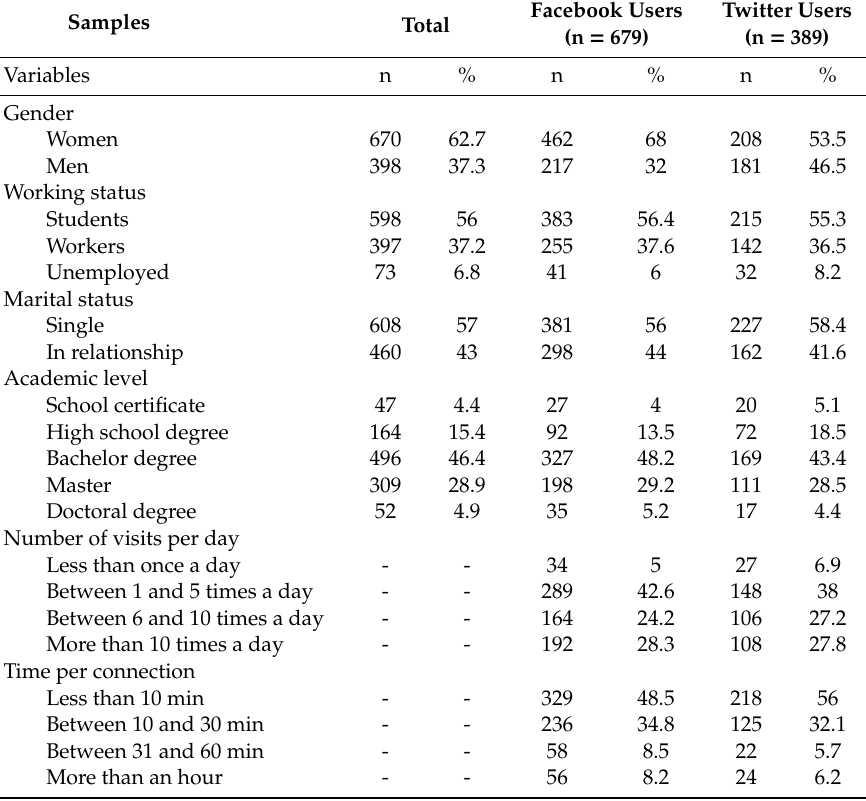
Table 1. General characteristics of the study